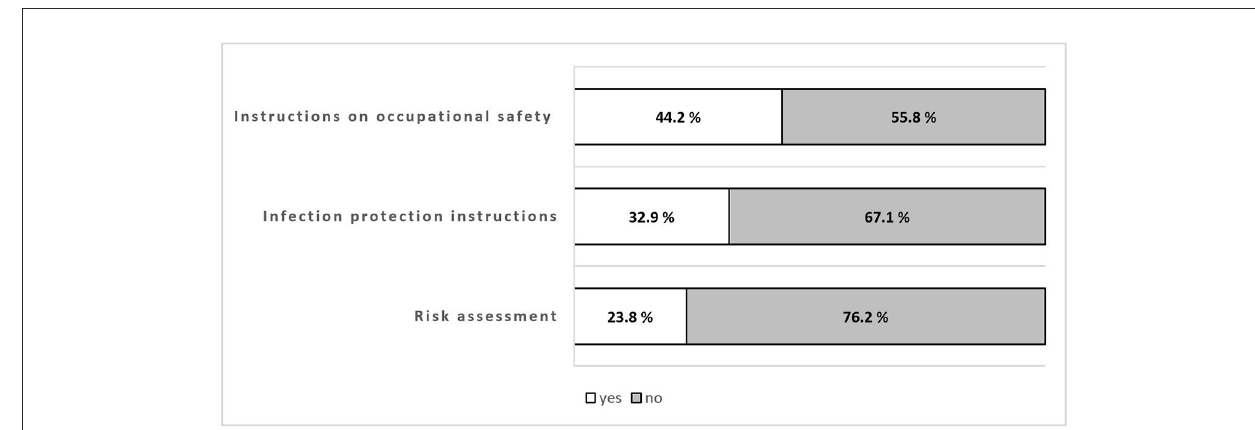
FIGURE2 Distribution of the implementation of individual occupational safety and health measures in German schools during the SARS-CoV-2 pandemic in March 2021.